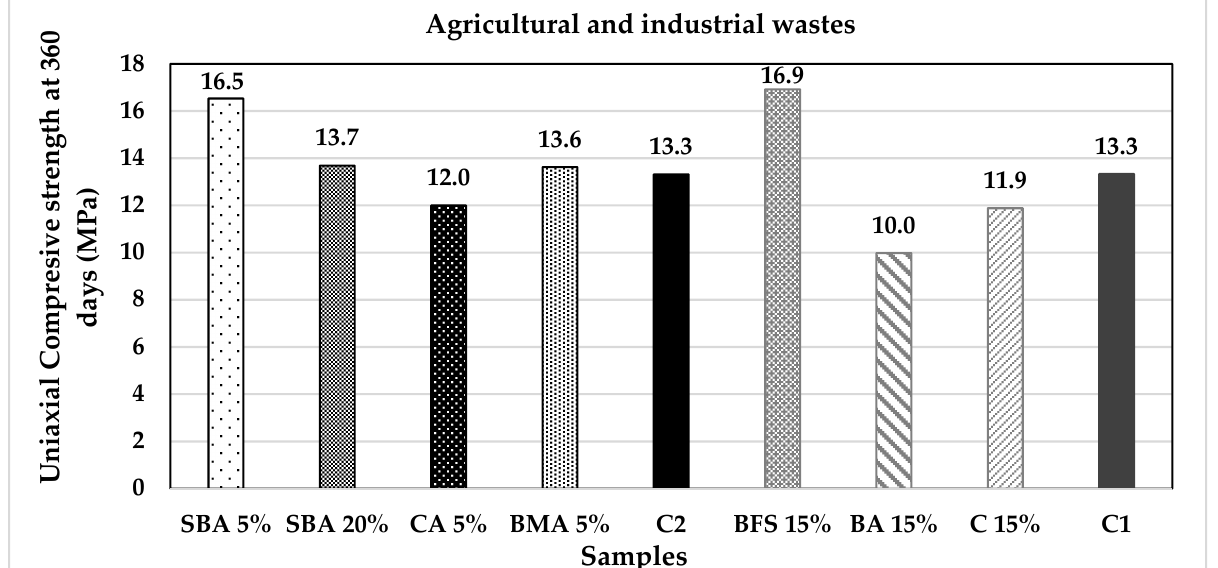
Figure 15. Uniaxial compressive strength of agricultural and industrial wastes group of additions.